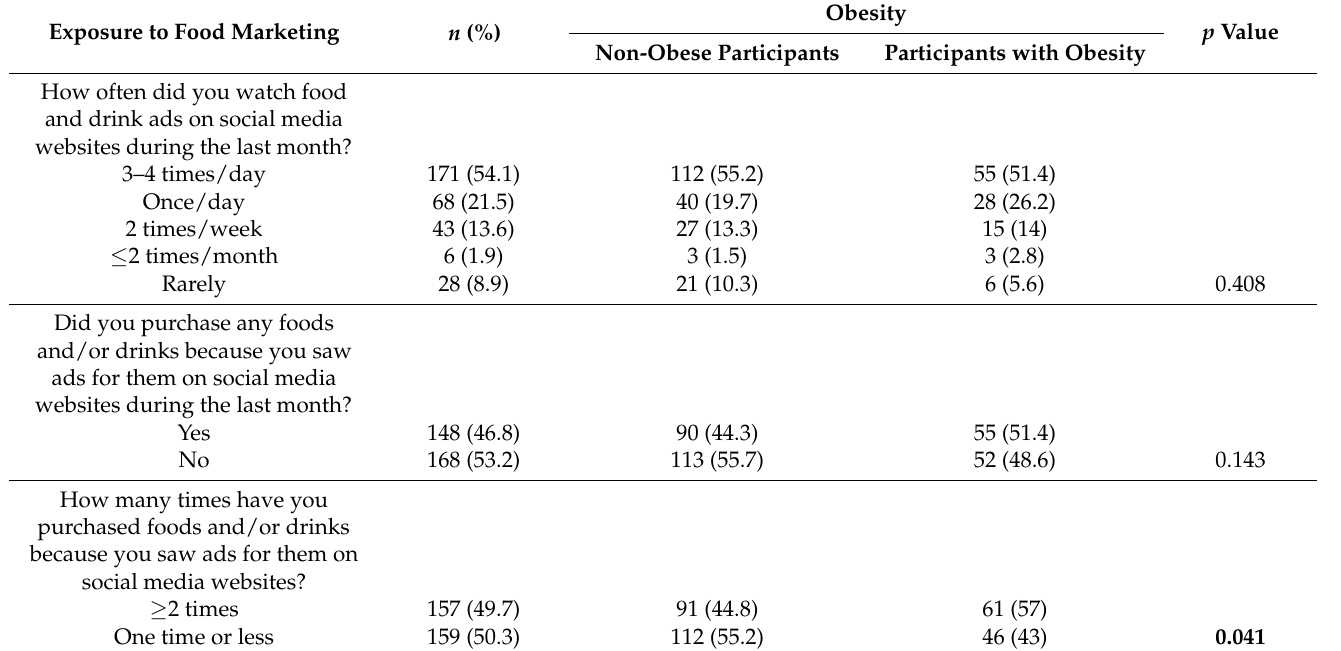
Table 3. Exposure to food marketing via social media platforms among the study participants according to their obesity